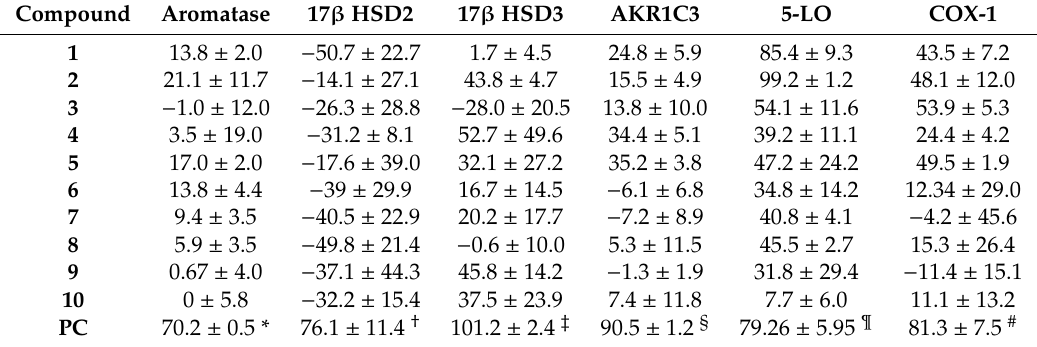
Table 3. In vitro inhibitory activities of compounds 1 – 10 towards targets of the DHC biological space, expressed as percent inhibition (0–100%) at 10- µ M compound concentration relative to the DMSO mock control. Shown is the mean of three independent experiments ( n = 3) plus / minus the standard deviation. Di ff erent compounds were used as positive controls (PC), as indicated in the Materials and Methods. Highly negative values of 17 β HSD2 assays are believed to be technical artefacts, as enzyme activation seems